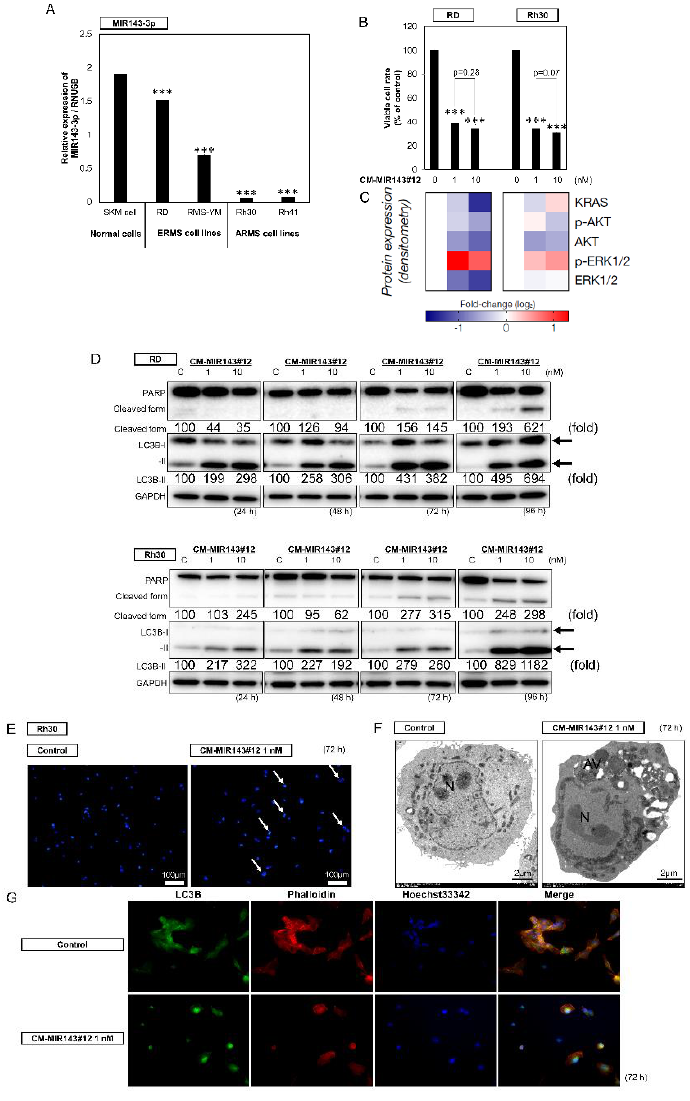
Figure 1. ( A ) Relative expression levels of MIR143 in normal skeletal muscle (SKM) cells and rhabdomyosarcoma cell lines (RD, Rhabdomyosarcoma (RMS)-YM, Rh30, and Rh41). ( B – D ) E ff ects of ectopic expression of CM-MIR143#12 on viability of RMS cells ( B ; Figure S2C) and expression of KRAS, AKT, ERK1 / 2 ( C ; Figure S2D), and levels of PARP, as an apoptotic marker, and LC3B, as an autophagic marker, as estimated using Western blot analysis ( D ) at 24, 48, 72, and 96 h after transfection of RD and Rh30 cells with CM-MIR143#12 at a concentration of 1 or 10 nM. ( E ) Hoechst 33,342 staining of Rh30 cells at 72 h after transfection with control RNA (1 nM; left) or CM-MIR143#12 (1 nM; right). Typical apoptotic features, such as chromatin condensation and fragmentation of nuclei, were observed (white arrows). ( F ) Morphological examination using electron microscopy. Rh30 cells were treated with control RNA or CM-MIR143 (1 nM) for 72 h. N: fragmented nuclei; AV: autophagosome. ( G ) Immunofluorescence of LC3B at 72 h after transfection of Rh30 cells with CM-MIR143#12 (1 nM). LC3B: green; cytoskeleton (phalloidin): red; nucleus (Hoechst 33342): blue. Results are presented as the mean ± SD; *** p < 0.001.